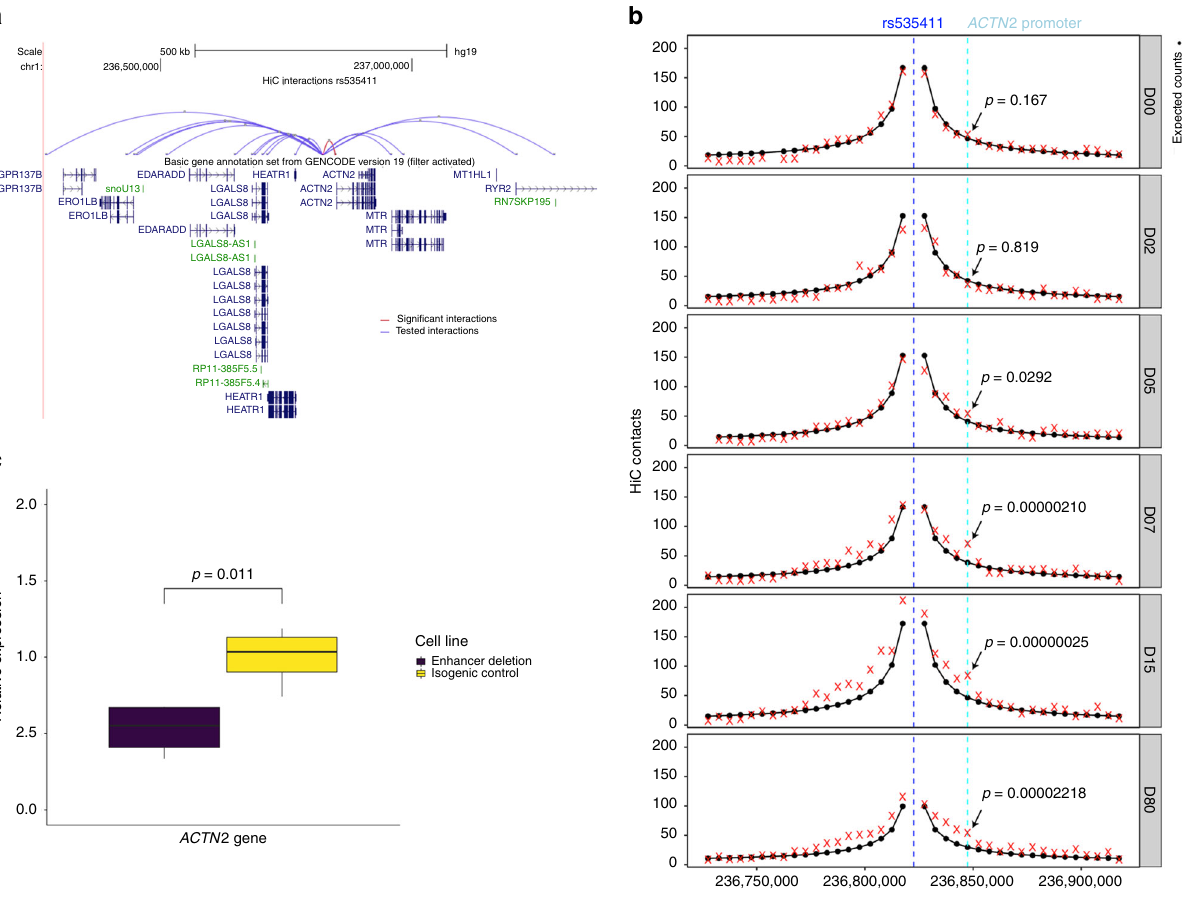
Fig. 4 The fi ne-mapped regulatory element in chromosome 1 affects ACTN2 gene expression. a HiC data from cardiomyocytes on Day 80 of differentiation for the interaction between the 5 Kb region containing rs535411 and the promoters of nearby (within 1 Mb) genes. Signi fi cant interactions after Bonferroni adjustment are colored red, while non-signi fi cant interactions (Bonferroni Poisson test p > 0.05, n = 2 independent biological replicates) are colored blue. b HiC data in different stages of cardiomyocyte differentiation centered at rs535411. Black lines/dots: expected interaction counts, which follow distance-based decay, red crosses: observed interaction counts, Blue dashed line: 5 Kb region containing rs535411, cyan dashed line: 5 Kb region containing ACTN2 promoter, p -value indicates the upper-tailed Poisson probability with the expected counts as lambda. N = 2 independent biological replicates. c Boxplot of relative expression of the ACTN2 gene in cardiomyocytes edited to produce a deletion of the identi fi ed putative enhancer element and isogenic controls ( n = 4 independent biological replicates). We see that expression of ACTN2 is reduced by 47% in the cardiomyocytes carrying the deletion. Boxplot center line represents the median, the bounds represent the interquartile range (IQR) (25 – 75%) and the whiskers extend from the bounds to the largest value no further than 1.5*IQR from the bound. Data beyond the end of the whiskers are plotted individually. Source data are provided as a Source Data fi